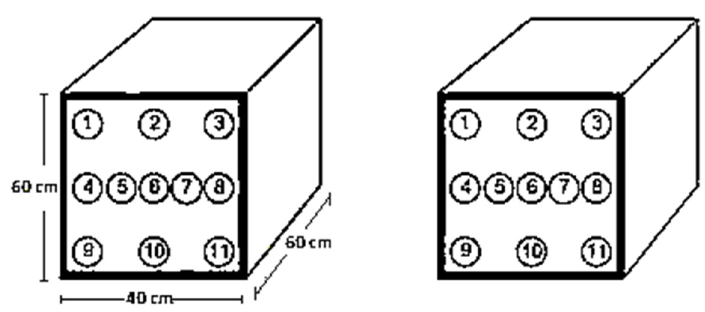
Figure 2. Core extraction pattern from massive concrete